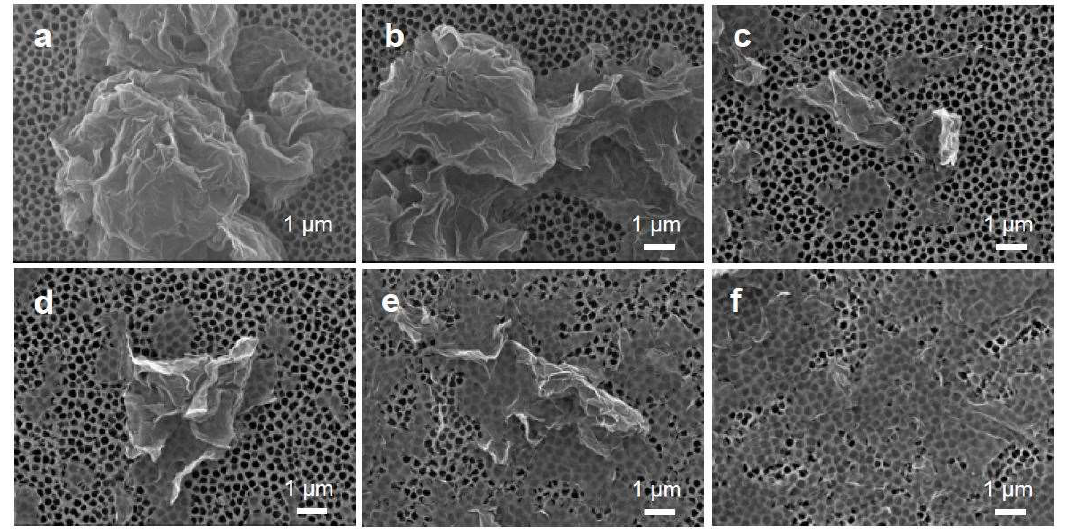
Figure 2. Scanning electron microscopy (SEM) images of rGO flakes placed on anodic aluminum oxide (AAO) membrane filters after sonication treatments for ( a ) 2, ( b ) 4, ( c ) 6, ( d ) 10, ( e ) 14, and ( f ) 20 h.